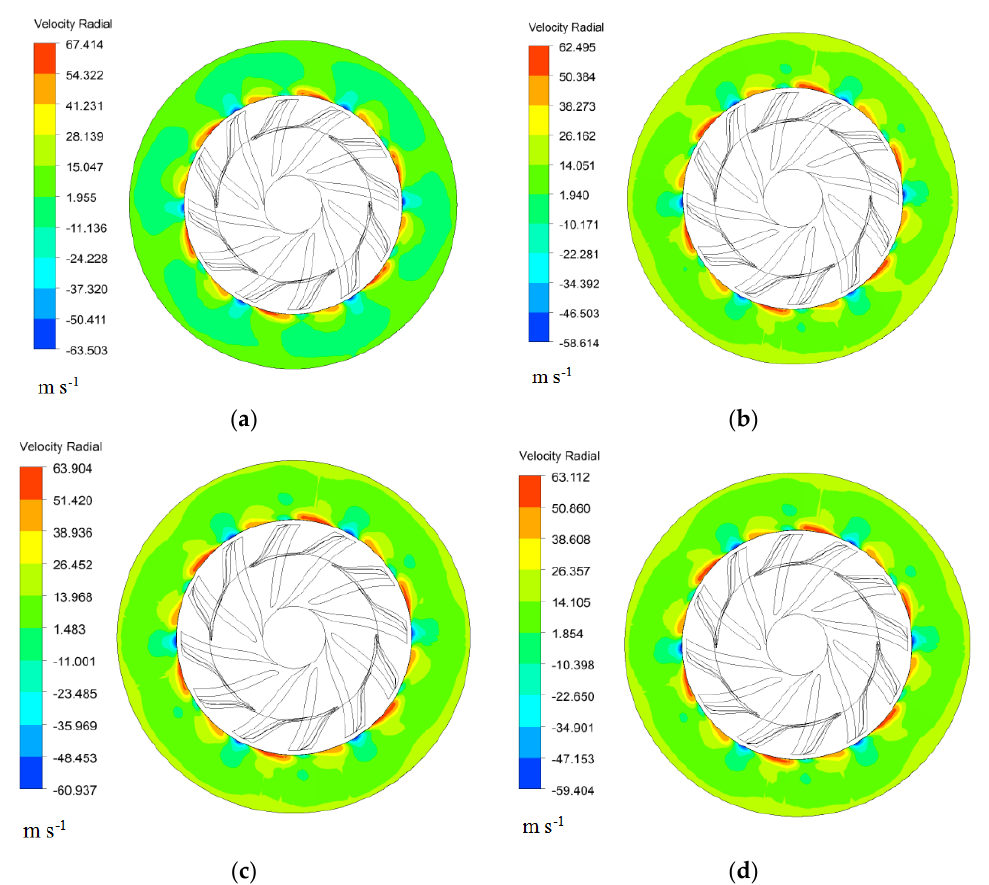
Figure 10. Seventy percent span height radial velocity distribution at 0.6 relative mass flow: ( a ) parallel; ( b ) convergence from shroud; ( c ) convergence from hub; ( d ) equal convergence from shroud and hub.